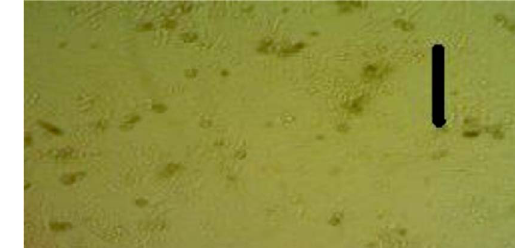
Fig. 5. The antiviral effect of the extract (10 -2 ) (the CPE appears after 48 hours) of the virus on the cell comparing with the normal negative control cells, lower than the concentration of 10 -1 (more CPE appear).